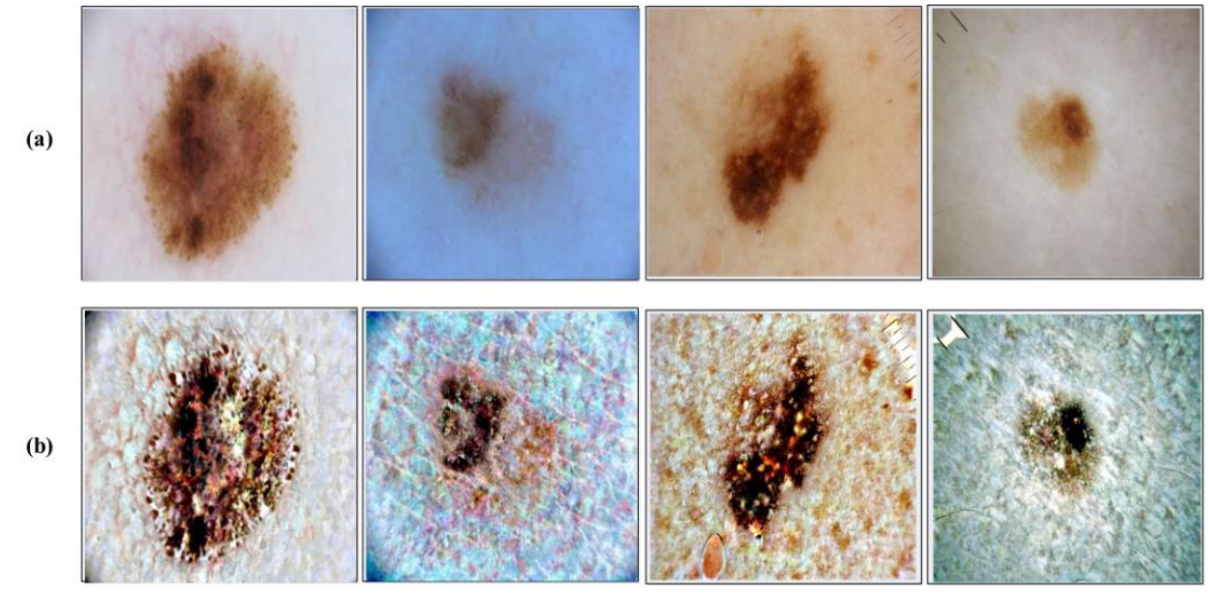
Figure 4. Contrast enhancement results. ( a ) Original dermoscopic images; ( b ) Proposed contrast enhancement.